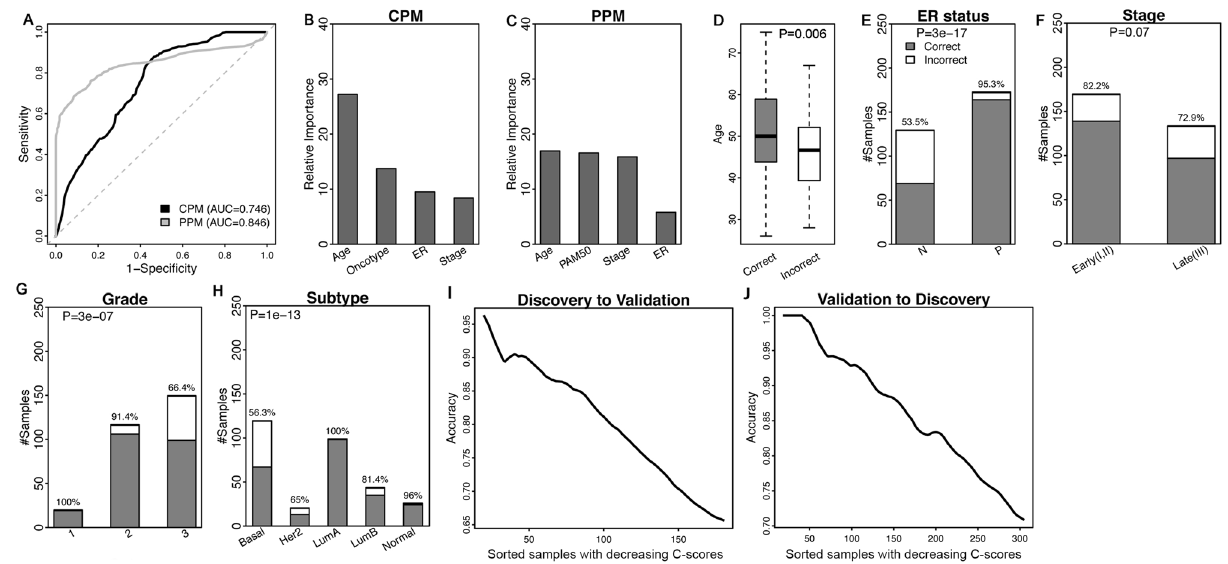
Figure 2. Predicting breast cancer patient response to neoadjuvant chemotherapy by using the Oncotype DX biomarker. To apply this biomarker, a clinical outcome prediction model (CPM) is used to predict the probability of pathologic complete response (pCR), and a predictability prediction model (PPM) is used to predict the applicability of this CPM to each patient. Both models are developed using random forest method. ( A ) The ROC curves of the CPM and the PPM calculated using the Hatzis discovery data. ( B ) The relative importance of predictors included in the CPM model. ( C ) The relative importance of predictors included in the PPM model. ( D ) Old patients are more likely to be corrected predicted. ( E ) ER+ patients are associated with higher prediction accuracy than ER- patients. ( F ) Low stage patients are more likely to be correctly predicted. ( G ) Low grade patients are more likely to be correctly predicted. ( H ) Association of molecular subtypes with prediction accuracy. ( I ) CPM and PPM are trained from the discovery data and then applied to predict the response and confidence score of patients in the validation cohort. Patients with higher confidence scores are more likely to be correctly predicted. Patients are sorted in the decreasing order of their confidence scores from the PPM, and the average prediction accuracy of the CPM in the top N patients were calculated from N = 1 to all patients. The curve was smoothed by averaging values within a sliding window of size 20. ( J ) Apply CPM/PPM trained from the validation data to predict patients in the discovery